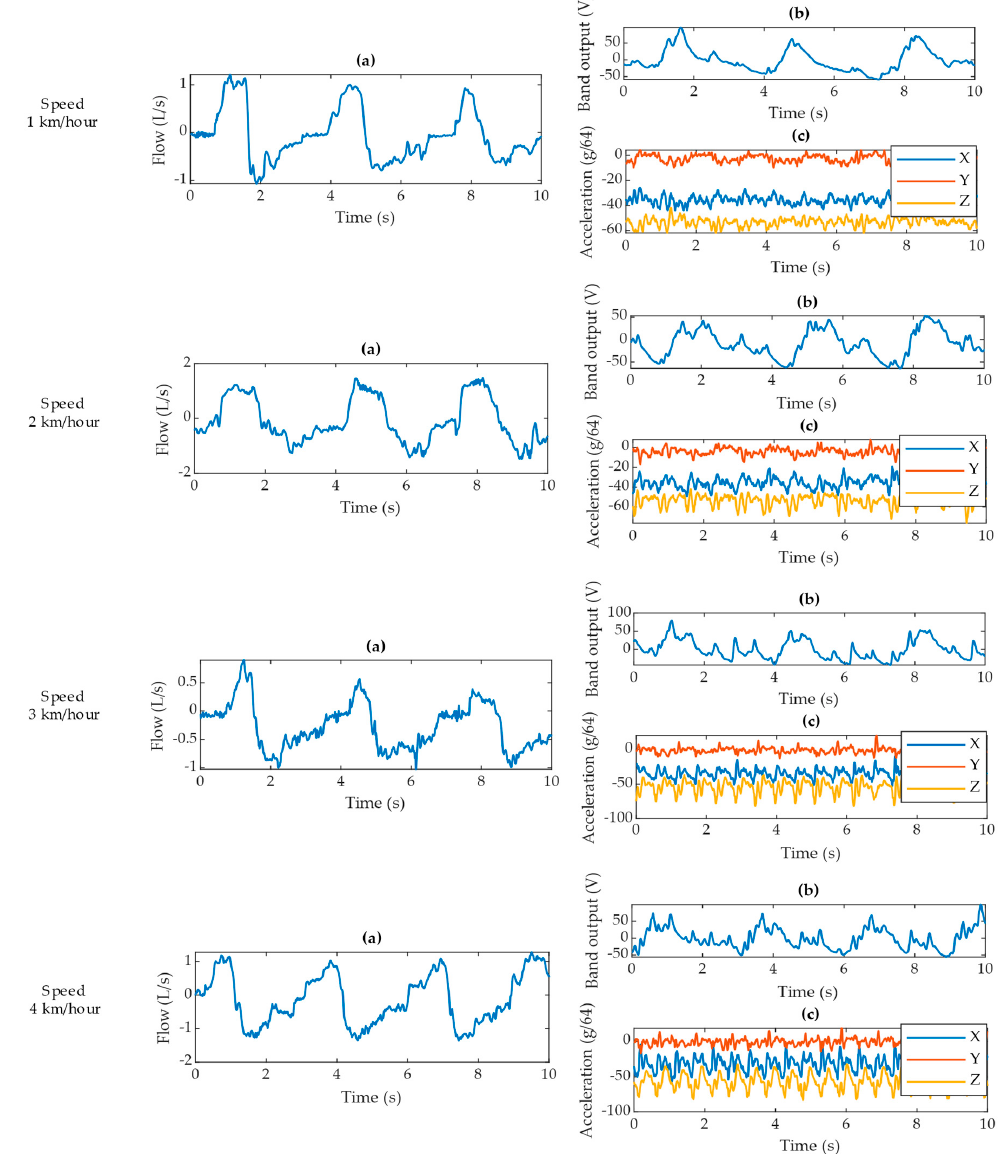
Figure 12. Data excerpts for each walking speed showing ( a ) pneumotach spirometer output, ( b ) corresponding VitalCore output from two bands, and ( c ) corresponding accelerometer readings from